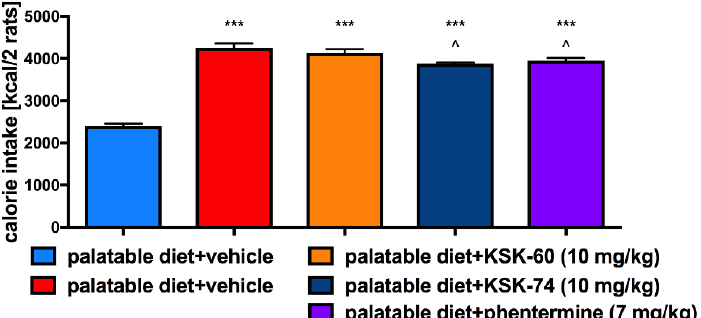
Figure 4. Effect of administration of the tested compounds or phentermine on calorie intake compared to control groups. Results are expressed as means ± SD, n = 3. Comparisons were made using the Kruskal–Wallis test followed by the Dunn post hoc test * Significant against control rats fed standard diet; * p < 0.05, ** p < 0.01.